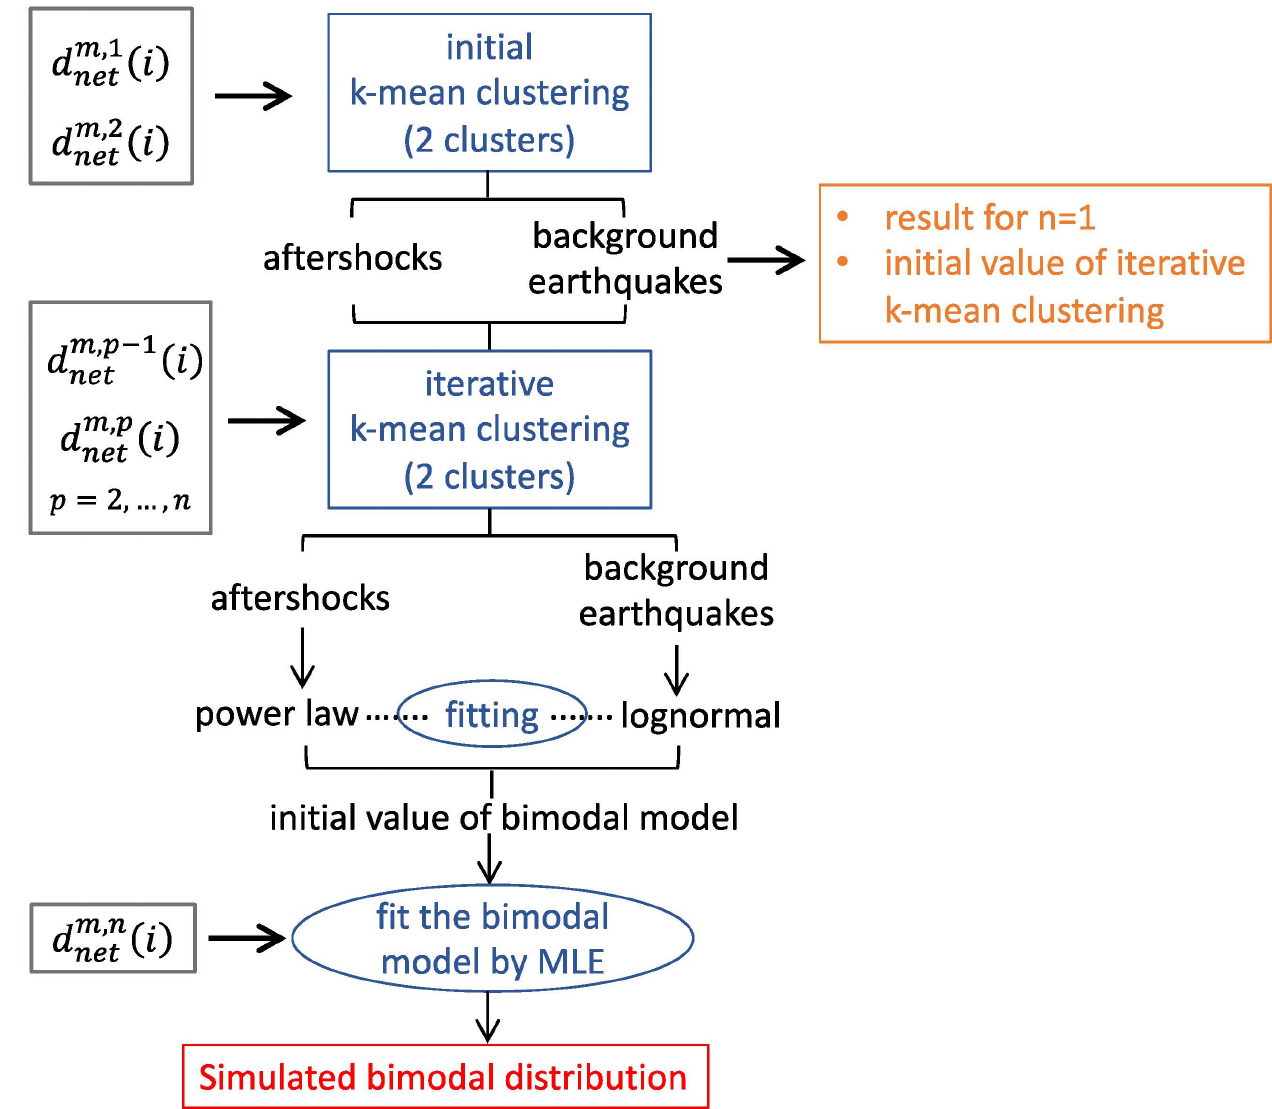
Figure 4. The flowchart of the data analysis. The network distances are imported into the k- mean clustering as the input data and be discriminated into two groups that are aftershocks and background earthquakes since the network distances of aftershocks are inherently shorter than background earthquakes, as illustrated in Figure 2, and can be recognized as a different group in k- mean clustering. In addition, each network distance corresponds to one event with magnitude m , and therefore, the interevent time of the aftershocks and the background earthquakes can be calculated according to the results of the k-mean clustering. Following all the steps, we can fit the network distances with a bimodal distribution as Figure 5 that would give a probability of successful prediction of the aftershock cluster. In addition, the relationships of network distance with the magnitude and interevent time for aftershocks and background earthquakes can be statistically